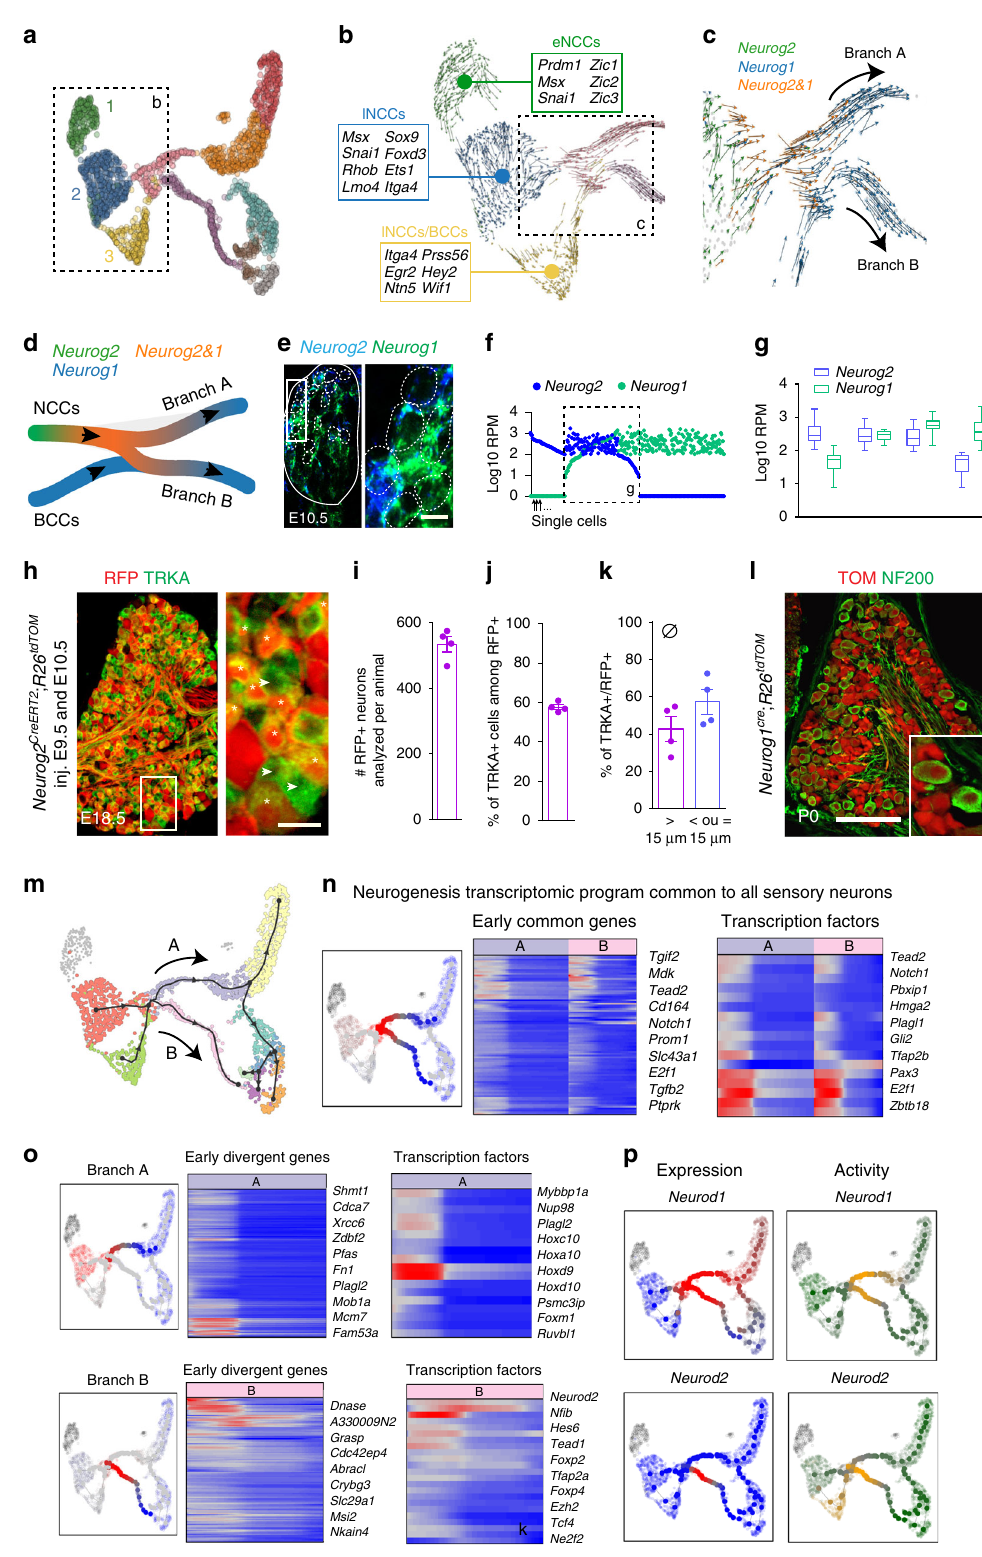
neurons proceed via different intermediate states demarcated by the expression of TFs, chromatin modi fi ers ( Prdm12 as previously shown 25 and Prdm8 ) and signaling molecules. Presumably, the dynamic local signaling landscape might in fl uence and bias the neuronal progenitors towards either branch A or B. Finally, separate GO term analysis on each of the gene sets (common